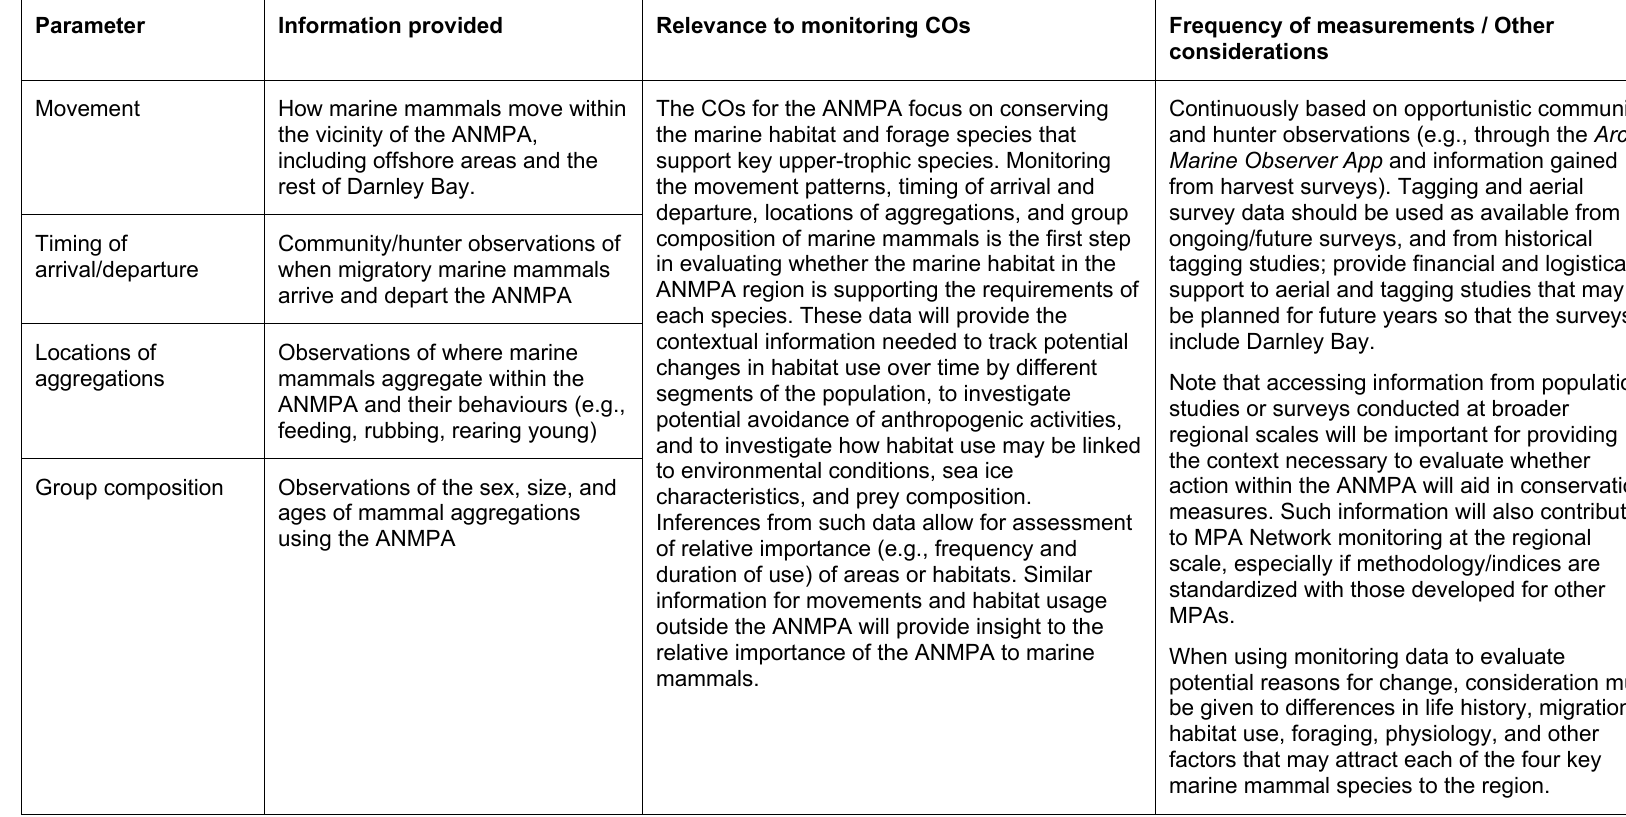
Table C6.10. Key measurement parameters for monitoring marine mammal presence/absence, timing, habitat use, and group composition (Section